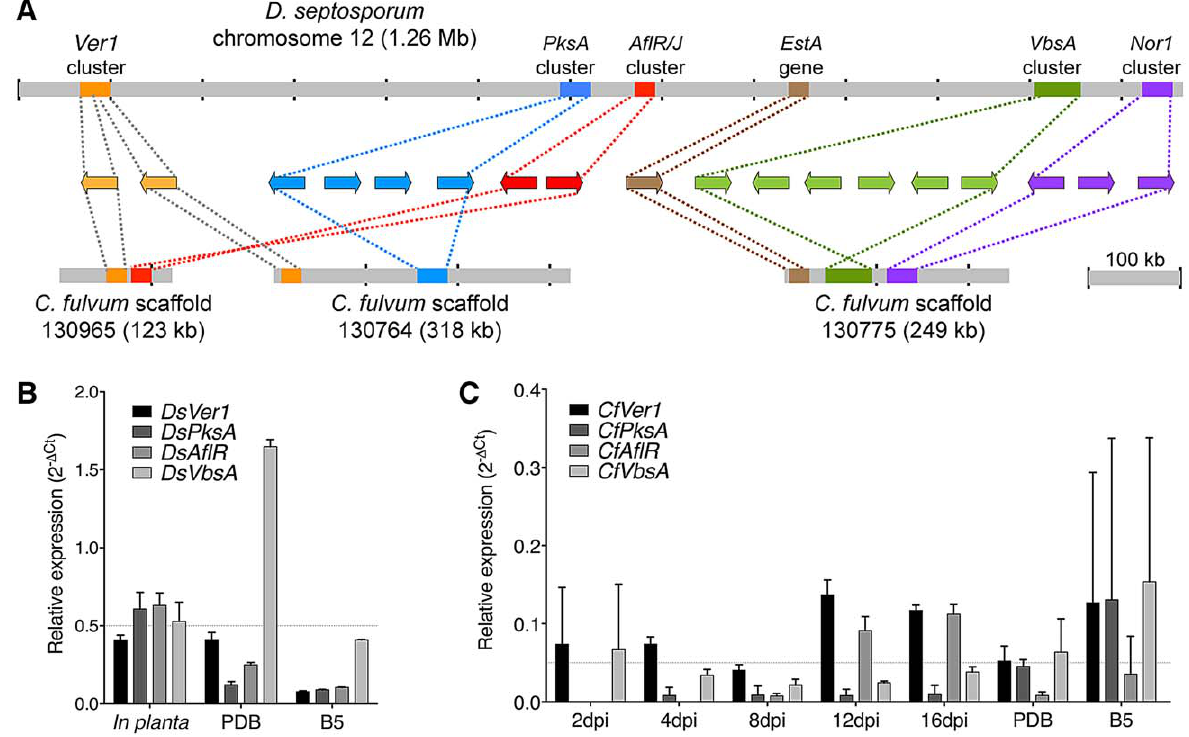
Figure 7. Arrangement of predicted dothistromin genes in Dothistromaseptosporum and Cladosporiumfulvum . A) Predicted dothistromin genes within the labeled clusters (left to right) are: Ver1, DotC ( Ver1 cluster); PksA, CypX, AvfA, MoxY ( PksA cluster); AflR, AflJ ( AflR/J cluster); OrdB , AvnA, HexB, HexA, HypC, VbsA ( VbsA cluster); Nor1, AdhA, VerB ( Nor1 cluster). Positions of mini-clusters are approximate and they are not drawn to scale. Dothistromin genes within the published D. septosporum PksA and VbsA clusters [36,38] and the newly discovered AflR/J and Nor-1 clusters are found in the same order and orientation in C. fulvum . B) Expression of dothistromin biosynthetic genes ( Ver1, PksA, VbsA ) and regulatory gene ( AflR ) was determined in D. septosporum by quantitative PCR. Mean expression and standard deviations are shown for at least 3 biological replicates relative to b -tubulin expression. In D. septosporum all genes but DsVbsA are expressed more highly in planta (late-stage sporulating lesions from a forest sample) than in culture (PDB or B5 media) as highlighted by the dashed-grey line. C) Expression of C. fulvum genes is shown as for (B), revealing that expression is not higher during tomato infection than in culture (dashed-grey line). Note the different scales for expression, which reveal a much lower level of transcription both in planta and in PDB medium compared to D. septosporum